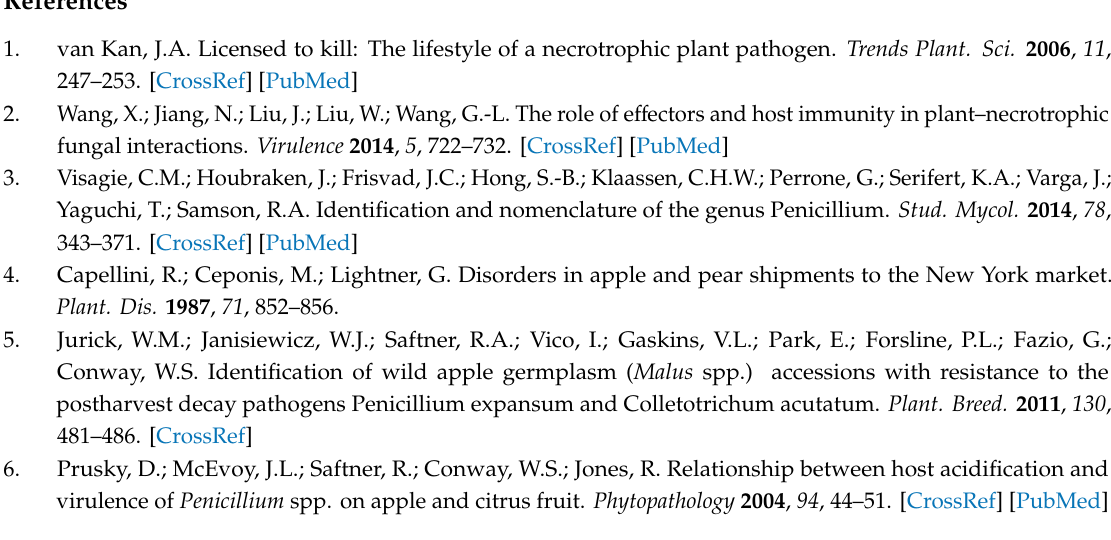
Table S1. Primers used in the study. Figure S1: Deletion of Penlp1 and Penlp2 in P. expansum PEX2. Figure S2. (A) Three splice variants of the Penlp2 gene. Spore suspensions of P. expansum were inoculated into 100 mL of potato dextrose broth (PDB) and were incubated for 3 to 4 days at 25 ◦ C in the dark. Full lengths ORF of Penlp1 and Penlp2 was amplified using PCR reaction and separated on agarose gel. Figure S2 (B) Schematic representation of the tree splice variants. Figure S3. Targeted deletion of Penlp1 or Penlp2 genes does not a ff ect radial growth and colony morphology. Figure S4. Targeted deletion of Penlp1 or Penlp2 genes had no significant e ff ect on spore-production or